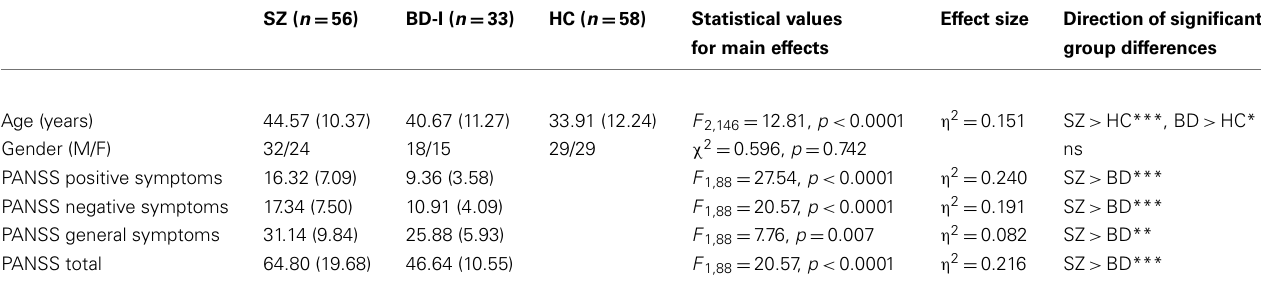
Table 1 | Demographic information and PANSS scores for each group.